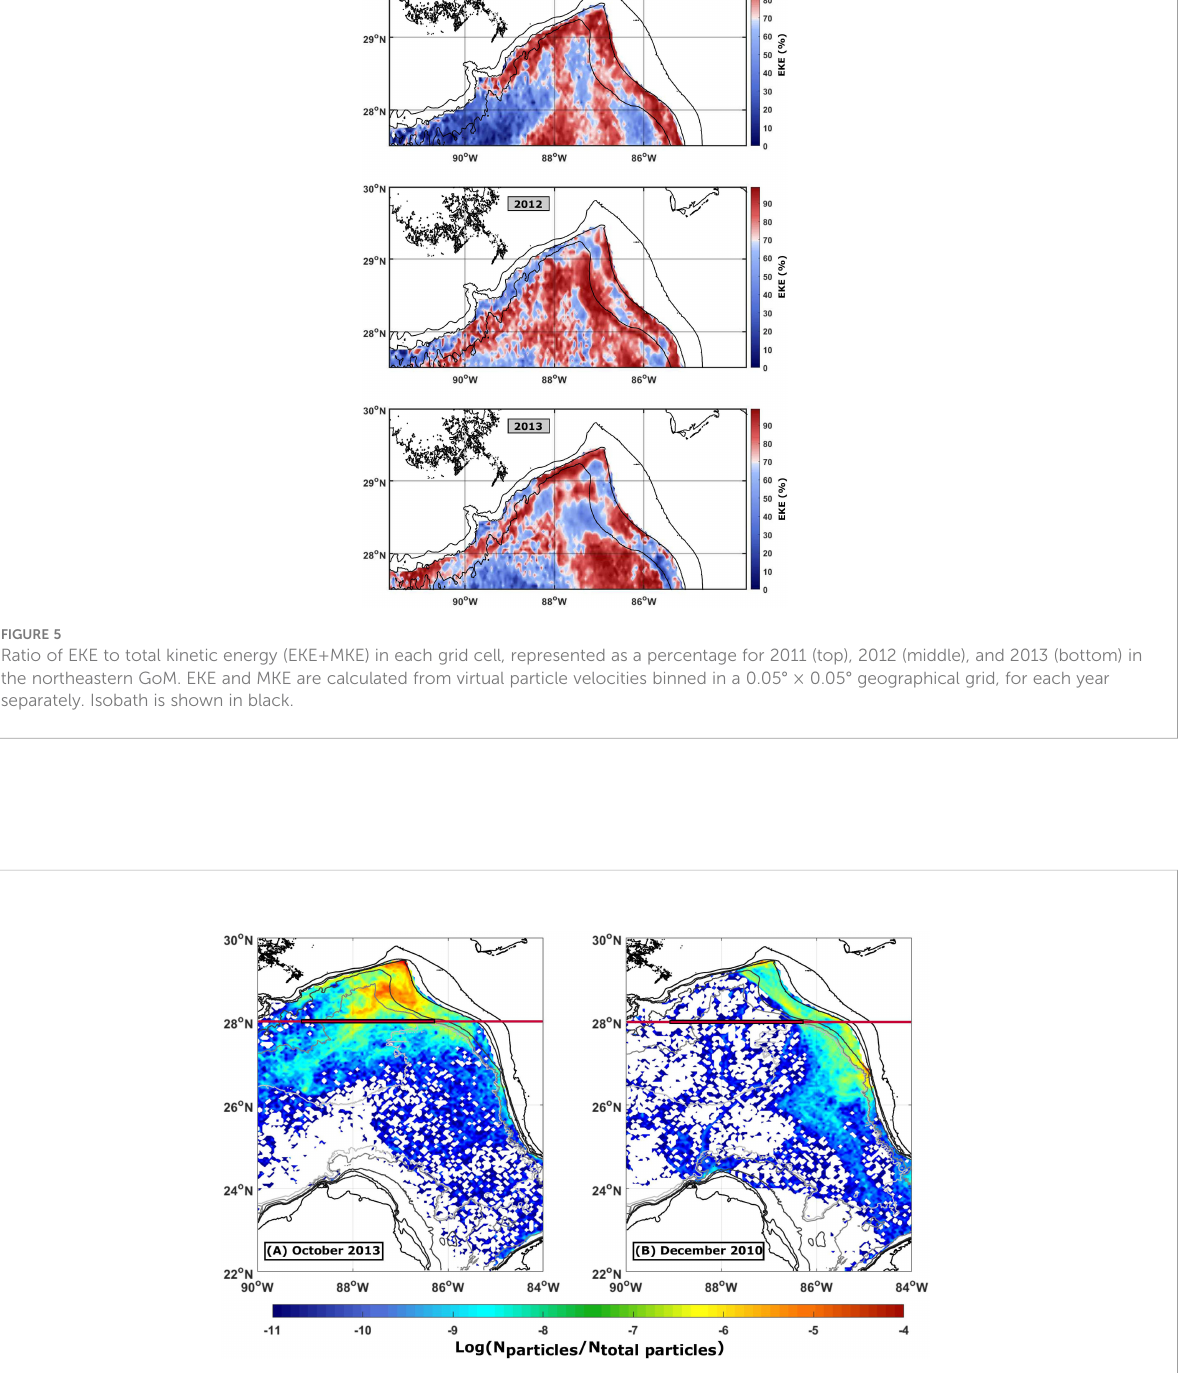
FIGURE 6 Density of virtual particles in each grid cell normalized by the total number of virtual particles in the domain, represented on a log scale for (A) October 2013 and (B) December 2010. Isobaths are shown with black and gray lines. The red line indicates 28°N, and the black outlined section indicates water depths greater than 1,500 m along